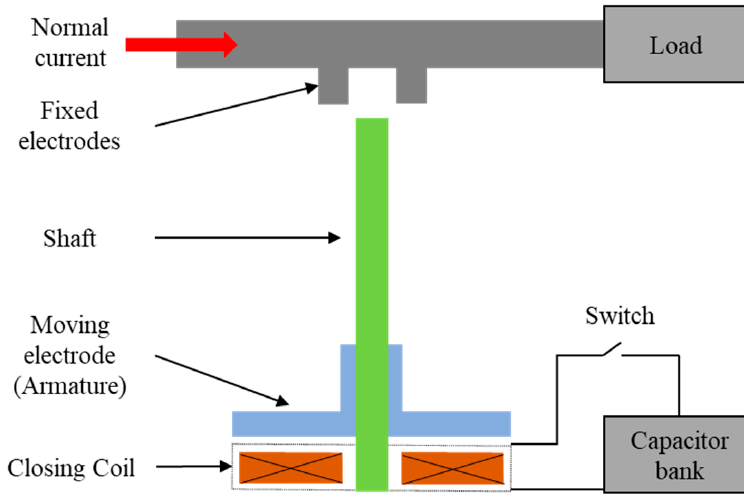
Figure 3. Transfer switch based on TCA, redrawn as depicted in [100].